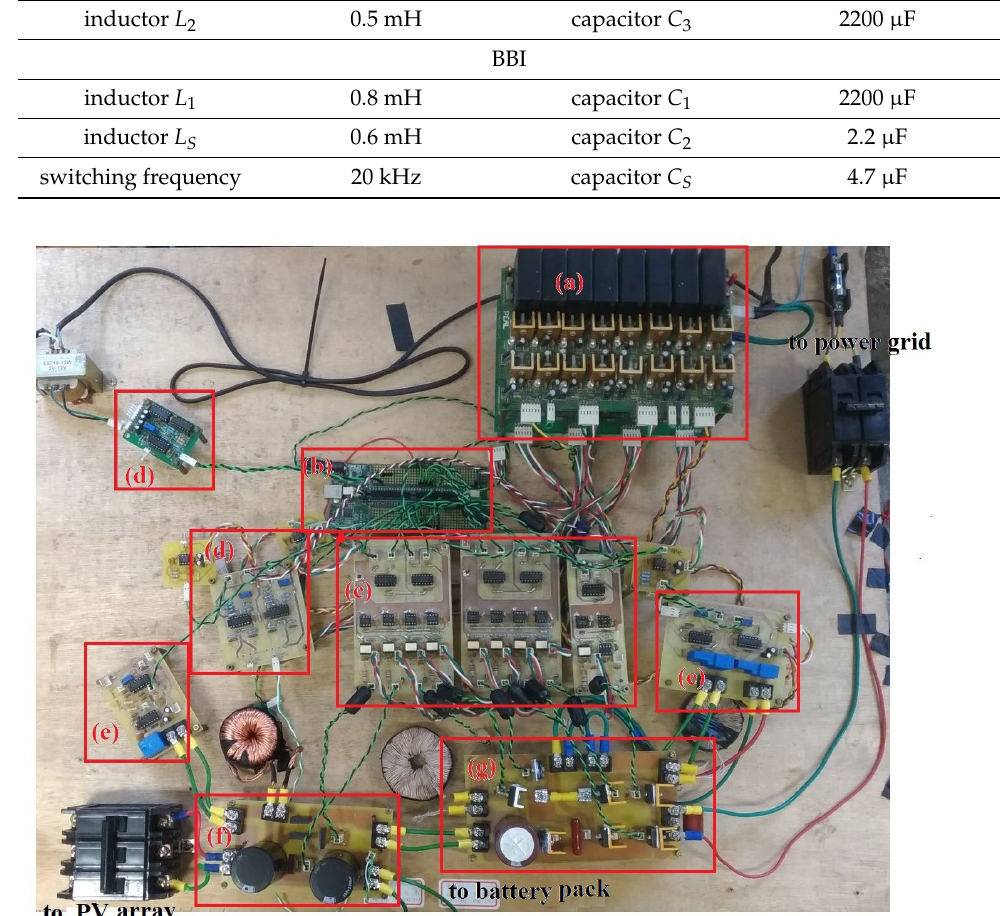
Figure 11. Picture of the prototype, ( a ) power supply, ( b ) DSP board, ( c ) driver board, ( d ) voltage detection board, ( e ) current detection board, ( f ) DDC, ( g ) BBI.